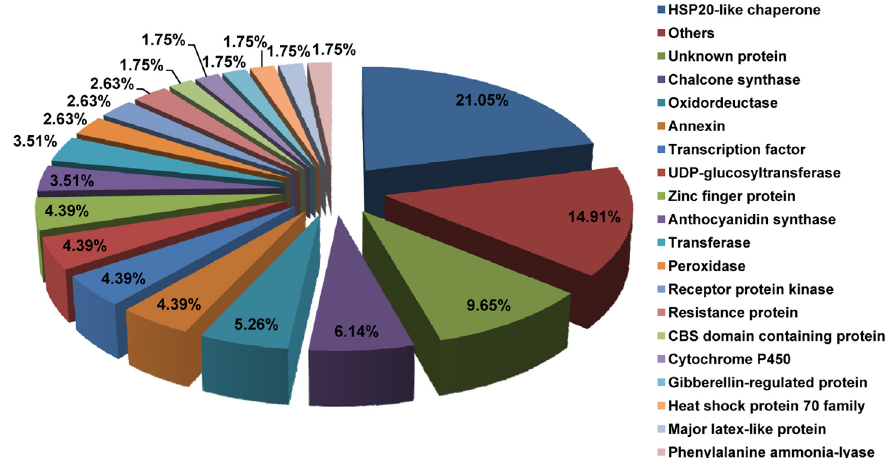
Fig 3. Functional categories of genes with changed expression between red- and white-fleshed apples.